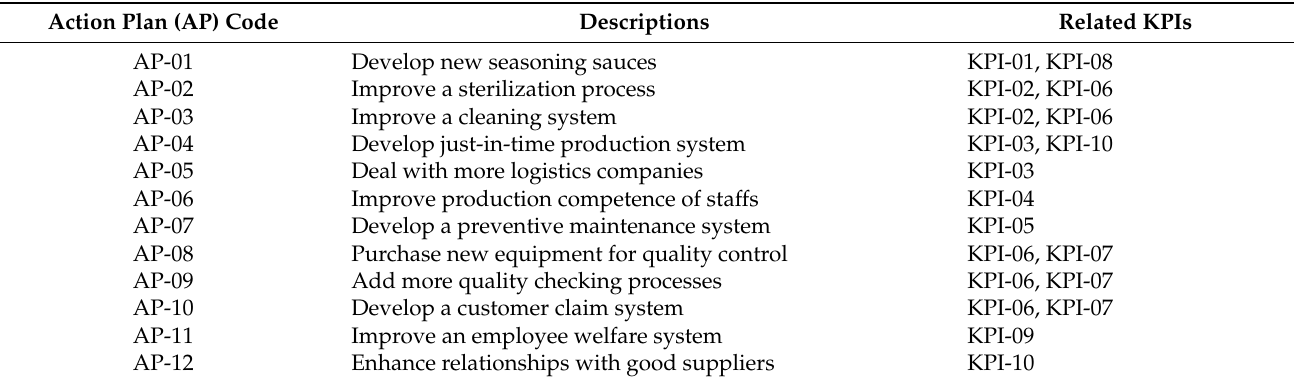
Figure 6. Results of the first house of QFD (QFD-I). Table 7. Action plans of the focused